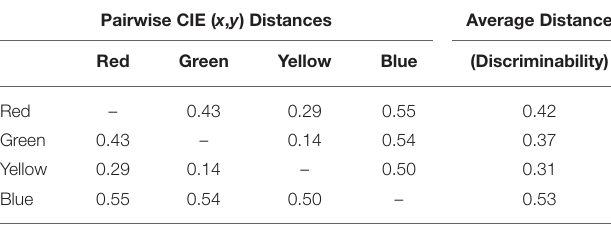
TABLE 1 | Distances in CIE ( x , y ) color space between each successive pair of color stimuli and the average distance of each color stimulus from the remaining color